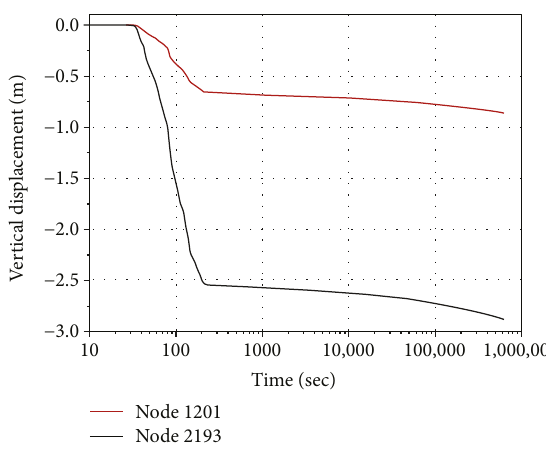
Figure 36: Time history of vertical displacement for 110